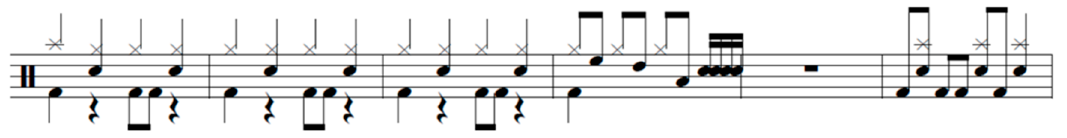
Figure 1. A drum score.